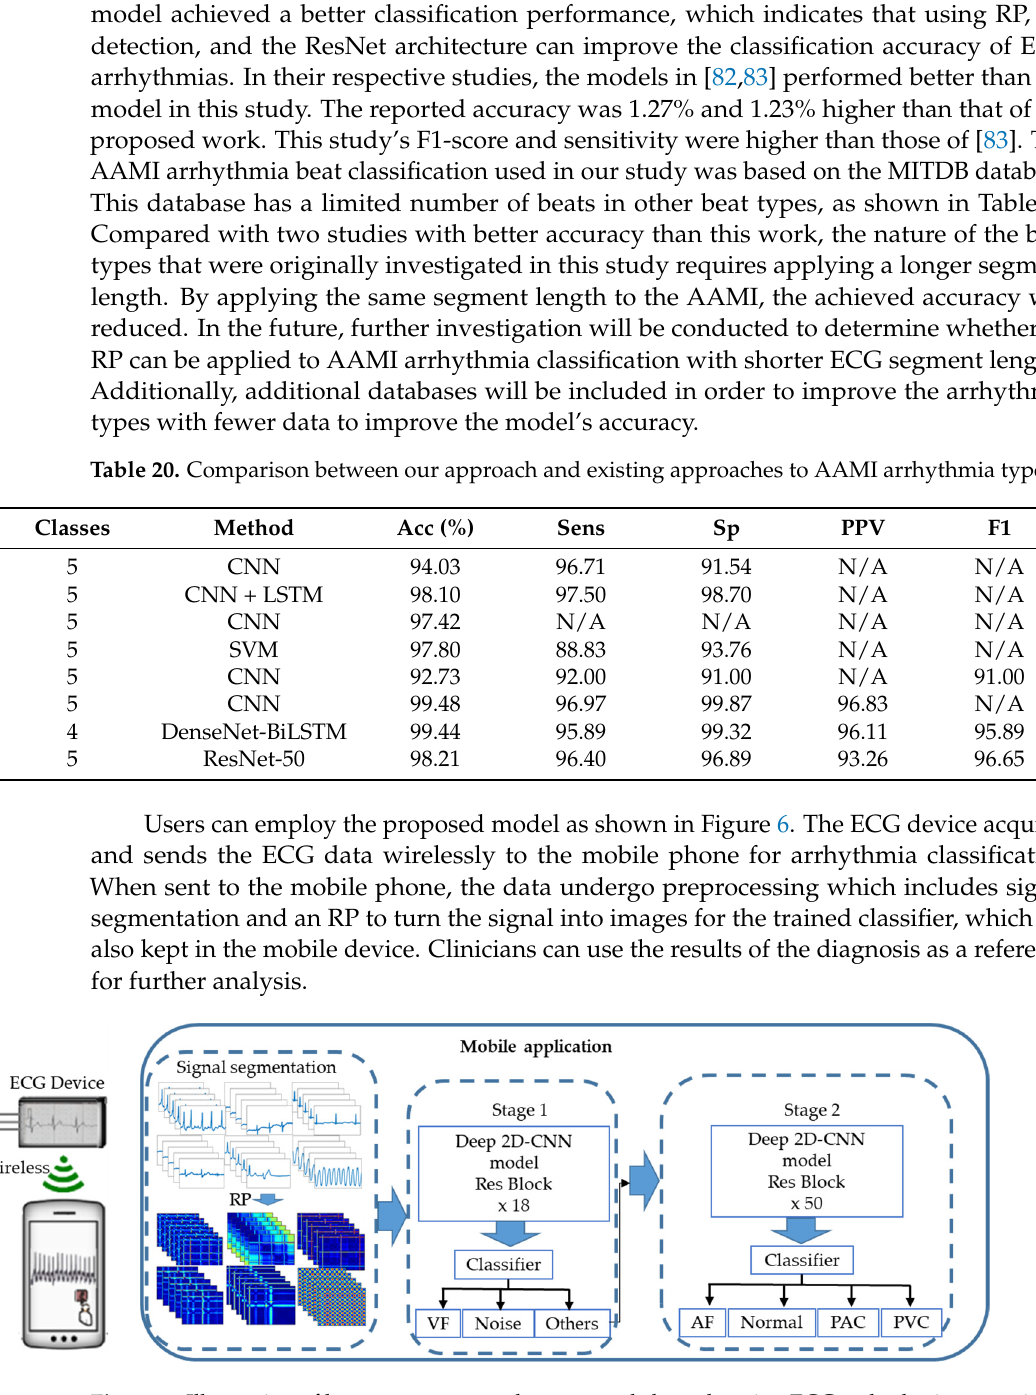
Figure 6. Illustration of how users can use the proposed short-duration ECG arrhythmia recogni- tion.